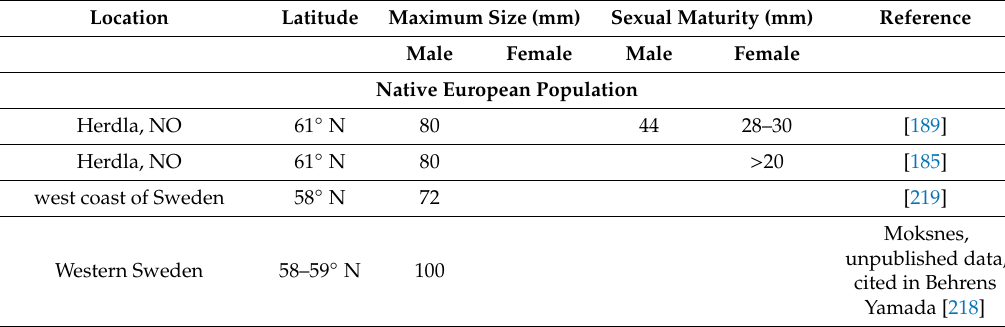
Table 2. Maximum size (CW) reported and minimum size at sexual maturity in various populations of C. maenas . When not stated in the reference, CW was estimated from graphs. (C) = combined sexes or sex not indicated. Empty cells indicate no data are available. No data are available for nonindigenous population in Australia. Latitude rounded to nearest whole